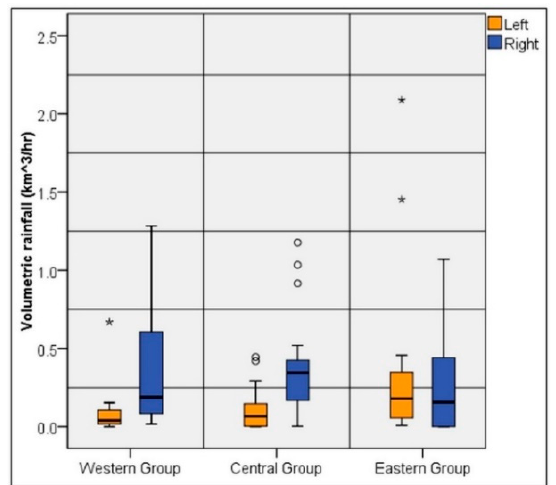
Figure 7. Boxplots for the volumetric rainfall on the left and the right sides of storms at t00 by groups. Circles (stars) denote values at least 1.5 (3) times the interquartile range.